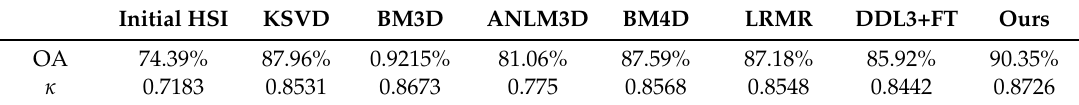
Table 2. SVM classification accuracies on the Indian Pines data (bands 104–108, 150–163, 220 removed).